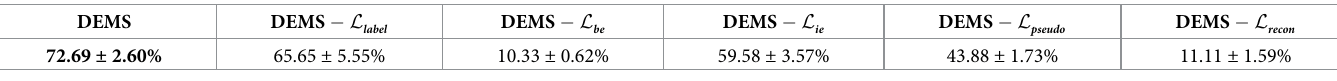
. Note that each of the loss significantly contributes to the accuracy of total